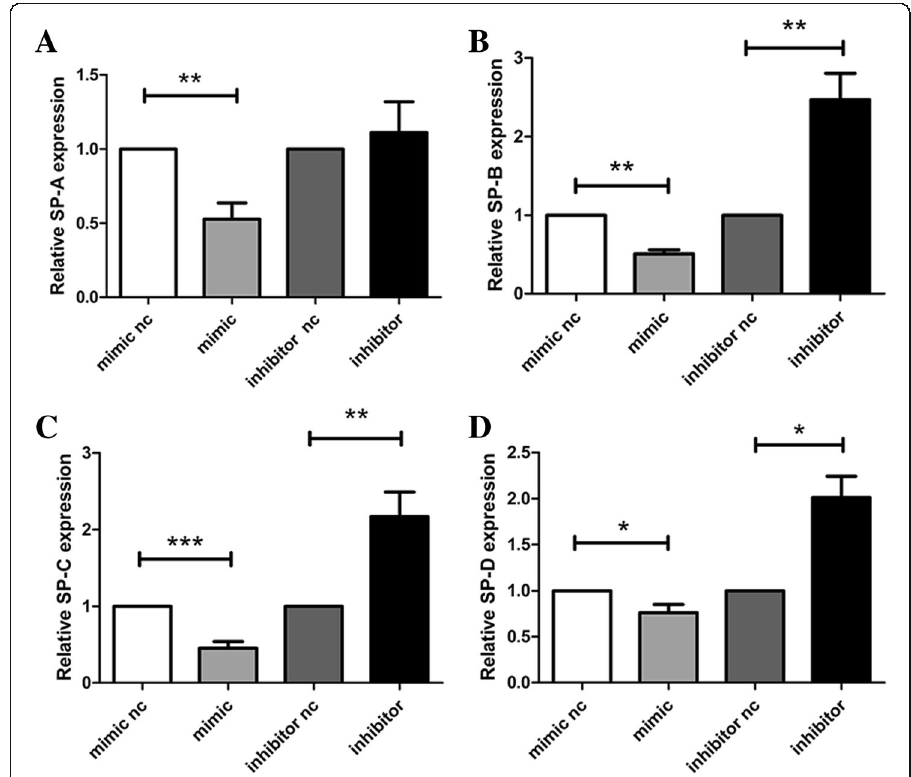
Fig. 6 Quantitative real-time PCR was used to detect the expression of surfactant proteins. a – SP-A mRNA expression in A549 cells. b – SP-B mRNA expression in A549 cells c – SP-C mRNA expression in A549 cells. d – SP-D mRNA expression in A549 cells. * p < 0.05; ** p < 0.01; *** p < 0.001 vs. miR-431-5p negative